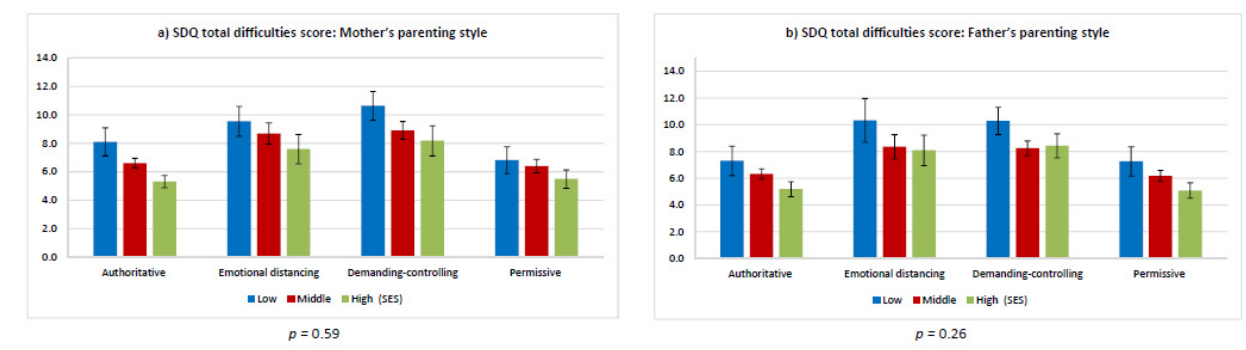
Figure 1. Predicted mean Strengths and Difficulties Questionnaire total difficulties scores stratified by parenting style and socioeconomic status (with 95% confidence intervals and p -values (joint Wald test)). ( a ) SDQ total difficulties scores: Mother’s parenting style. ( b ) SDQ total difficulties scores: Father’s parenting style.